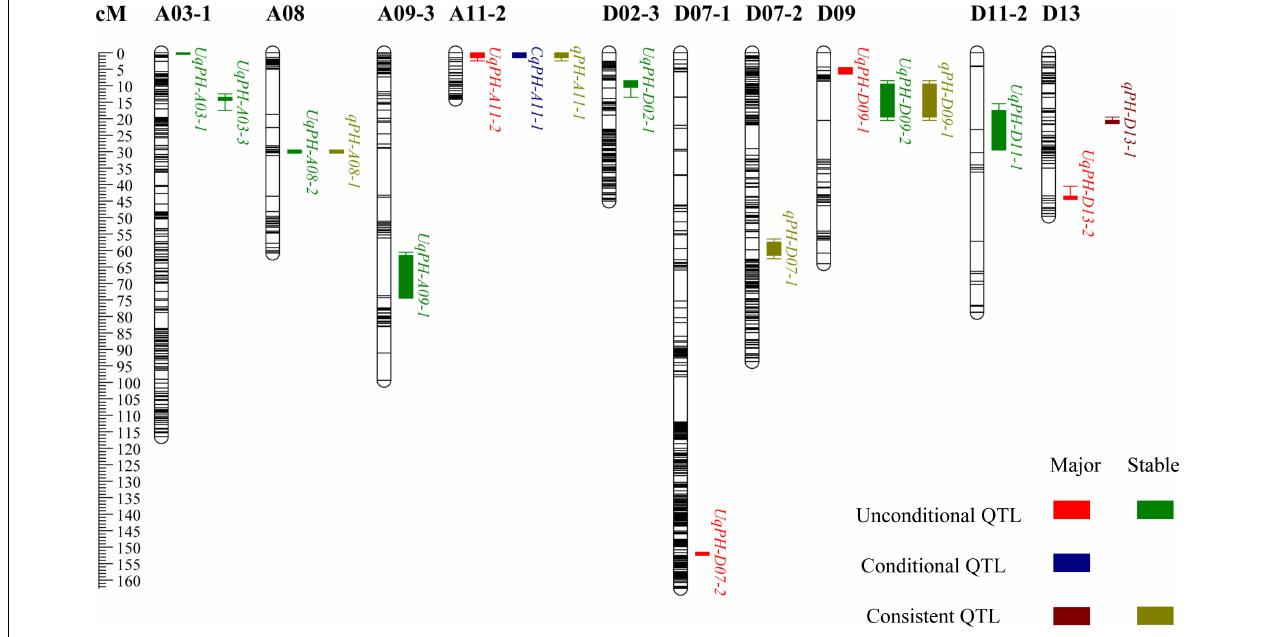
FIGURE 3 | The chromosome-wise distribution of plant height quantitative trait loci (QTL).